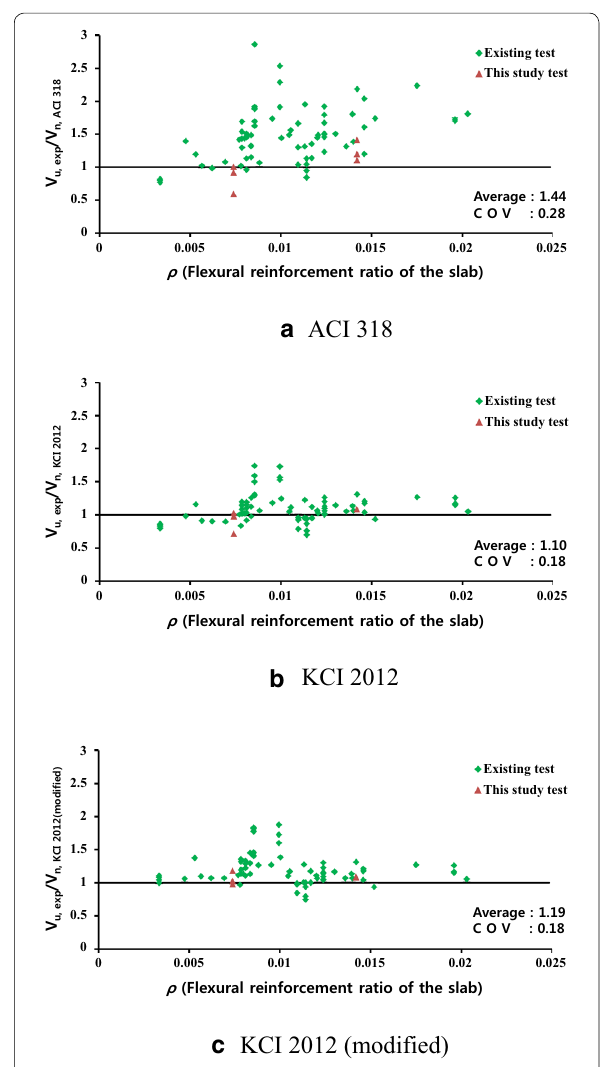
Fig. 10 Comparison of punching shear strengths by concrete code and proposed method (with existing test